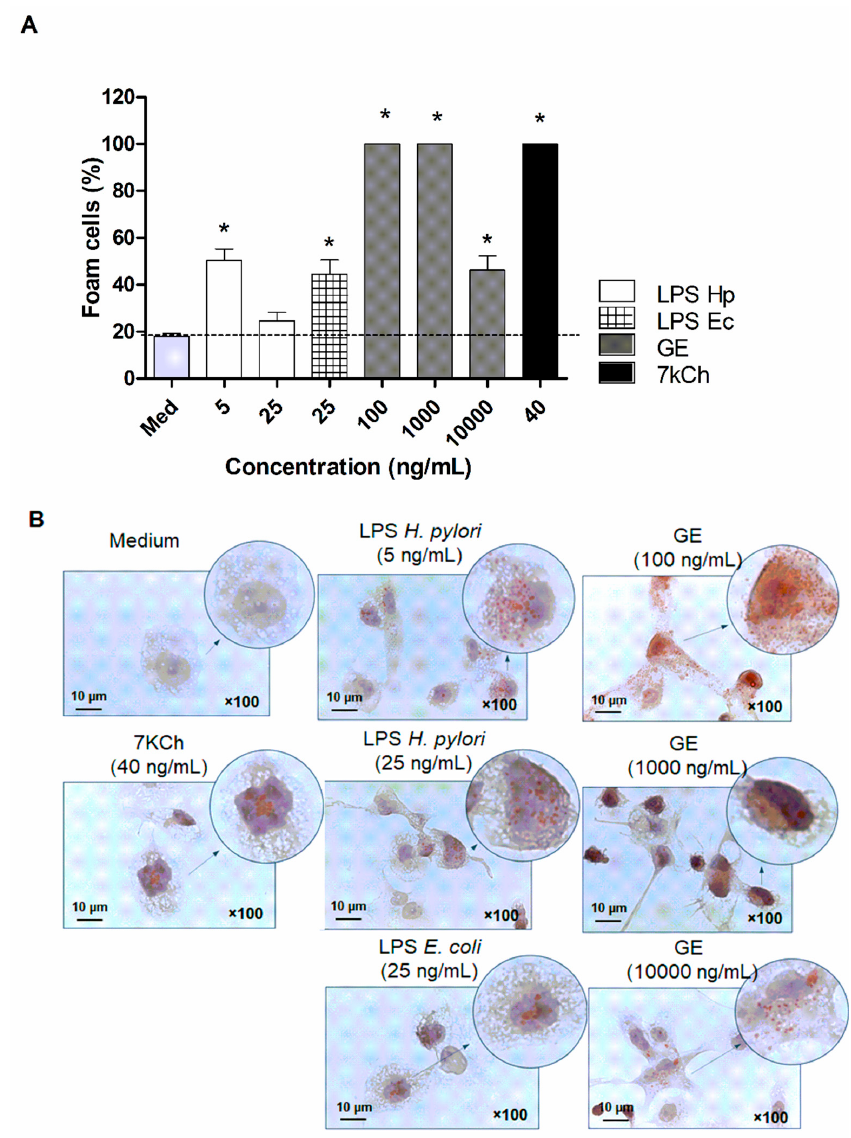
Figure 6. Transformation of THP-1 macrophages into foam cells. ( A ) Percentage of foam cells developed from THP-1 macrophages treated with an H. pylori antigenic complex—glycine acid extract (GE), lipopolysaccharide of H. pylori (LPS Hp) and E. coli (LPS Ec), and 7 ketocholesterol (7 kCh). Results are presented as the mean values ± SD. Statistical analysis was performed with the nonparametric Kruskal–Wallis test. Statistical significance, * p < 0.05, was obtained for THP-1 macrophages treated with the stimulators vs. control cells. ( B ) Representative pictures of the foam cells analyzed with light microscopy at a 1000× magnification.